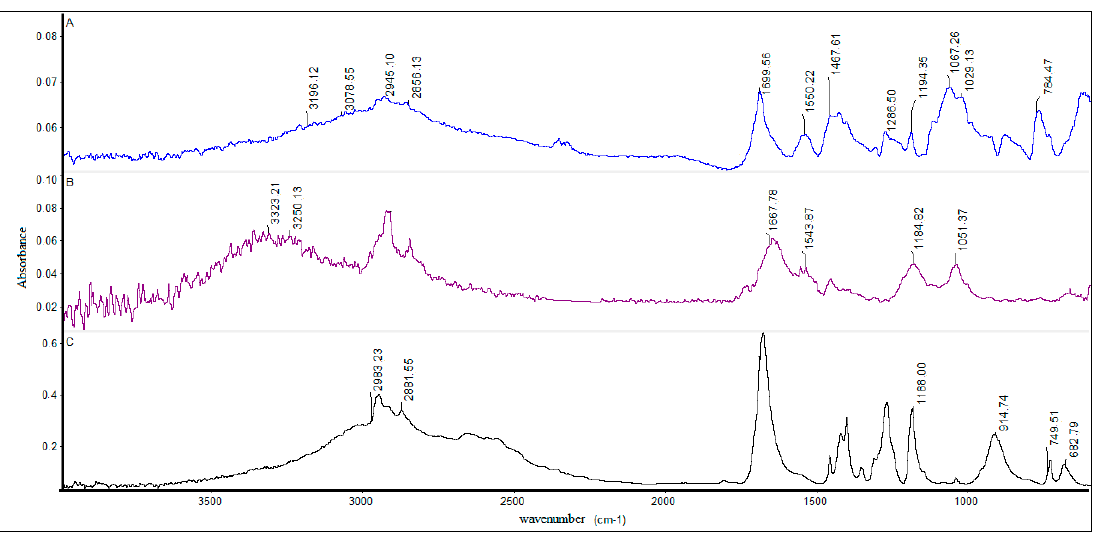
Figure 6. FTIR spectra of HMW chitosan: ( A ) dissolved in adipic acid; ( B ) isolated from the peritoneal cavity ten days after chitosan injection; ( C ) isolated from precipitated material in the granuloma 35 days after chitosan injection.